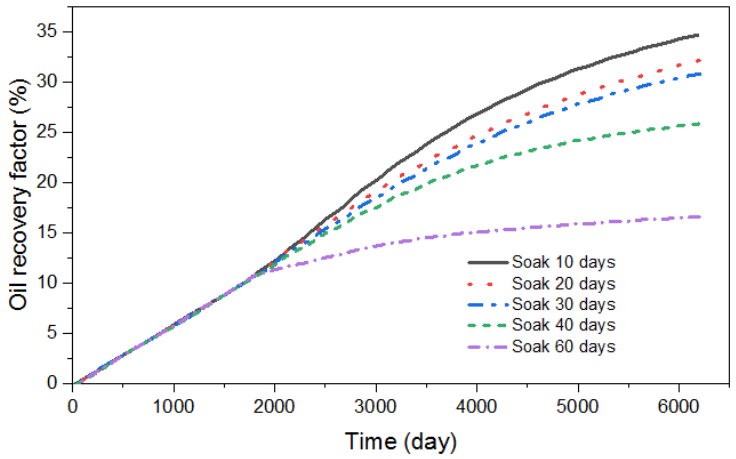
Figure 21. The comparison of huff-n-puff oil recoveries under different soaking